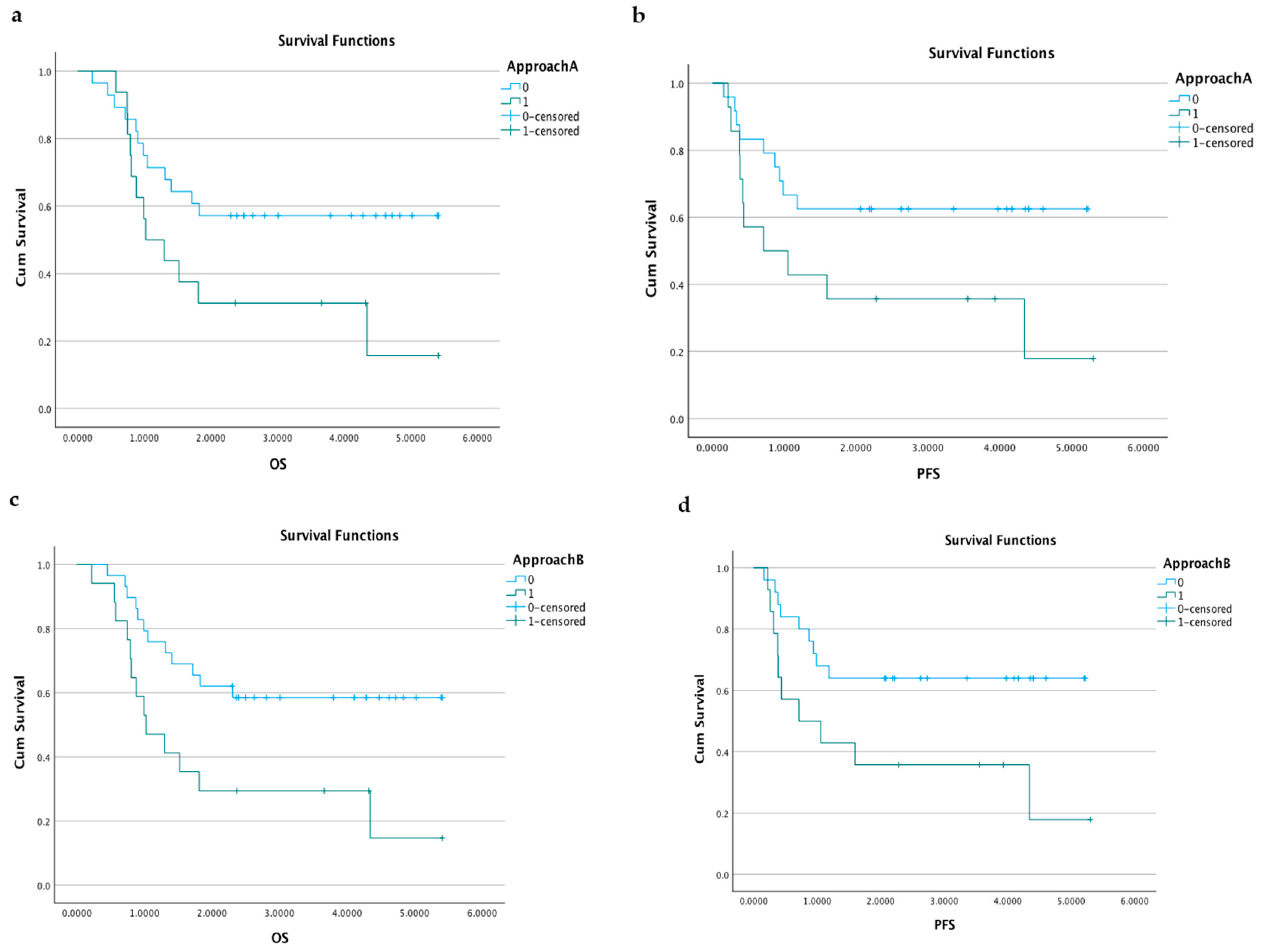
Figure 5. Kaplan–Meier curves. Kaplan–Meier curves of overall survival and progression-free sur- vival, in correlation with detectable ctDNA (1, green curve) and no detectable ctDNA (0, blue curve) in the diagnostic plasma sample: ( a ) Kaplan–Meier curve of the overall survival based on ctDNA detection using approach A (denominated according to Figure 2) for the diagnostic sample. Log rank p = 0.048. ( b ) Kaplan–Meier curve of progression-free survival based on ctDNA detection using approach A (denominated according to Figure 2) for the diagnostic sample. Log rank p = 0.049. ( c ) Kaplan–Meier curve of the overall survival based on ctDNA detection using approach B (denomi- nated according to Figure 2) for the diagnostic sample. Log rank p = 0.011. ( d ) Kaplan–Meier curve of progression-free survival based on ctDNA detection using approach B (denominated according to Figure 2) for the diagnostic sample. Log rank p = 0.03. The survival times and censoring are also